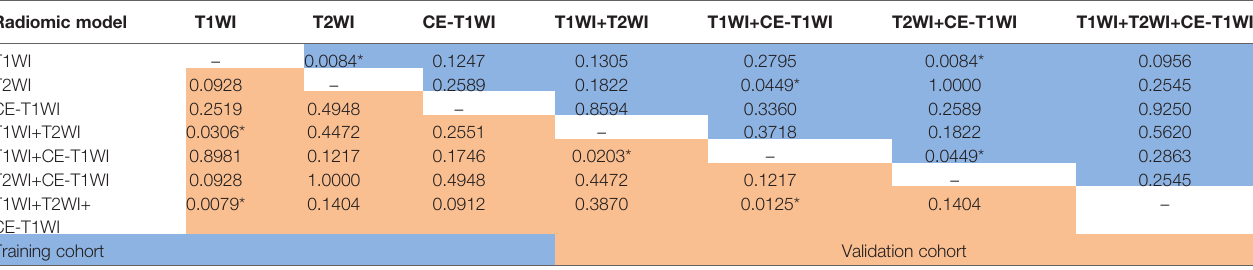
TABLE 12 | The ROC curve of clinical features, radiomic, clinical features + radiomic model in the training cohort. Model AUC 95% CI Sensitivity Speci fi city Clinical